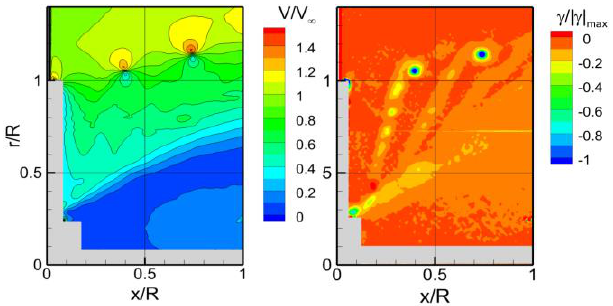
Fig. 4 Average velocity (left) and vorticity field (right),